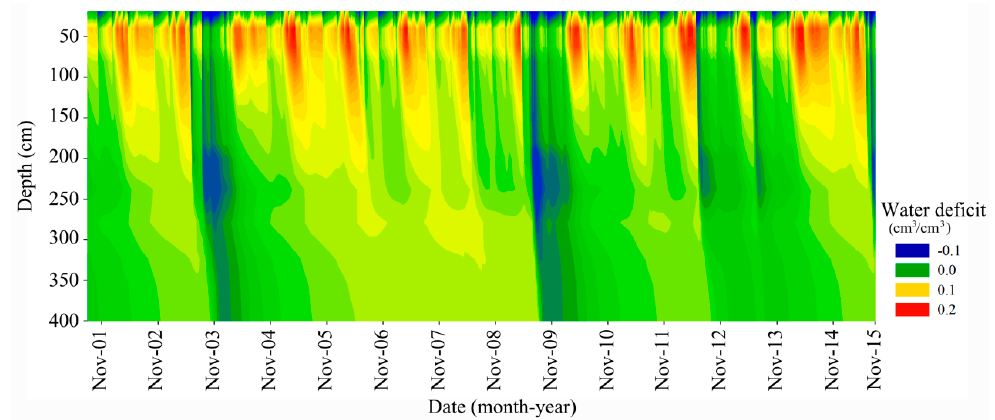
Figure 10. Changes in soil water deficit at different soil depths under the S2 scenario with 15 years of brackish water irrigation in the Hebei Low Plains study area in North China.